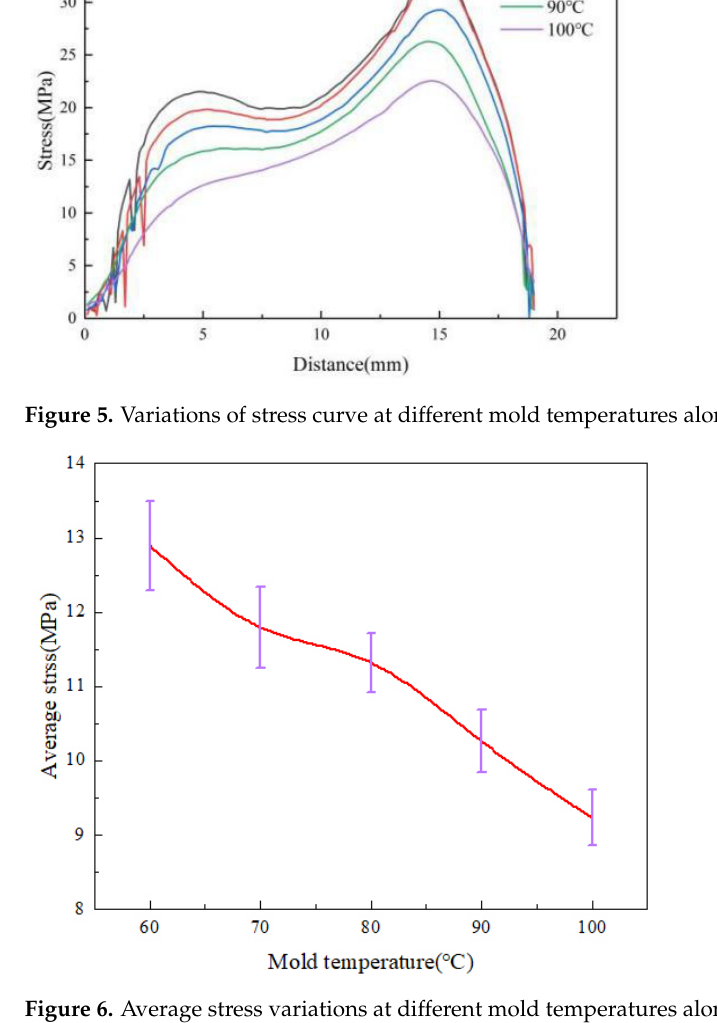
Figure 6. Average stress variations at different mold temperatures along the center line of the parts.